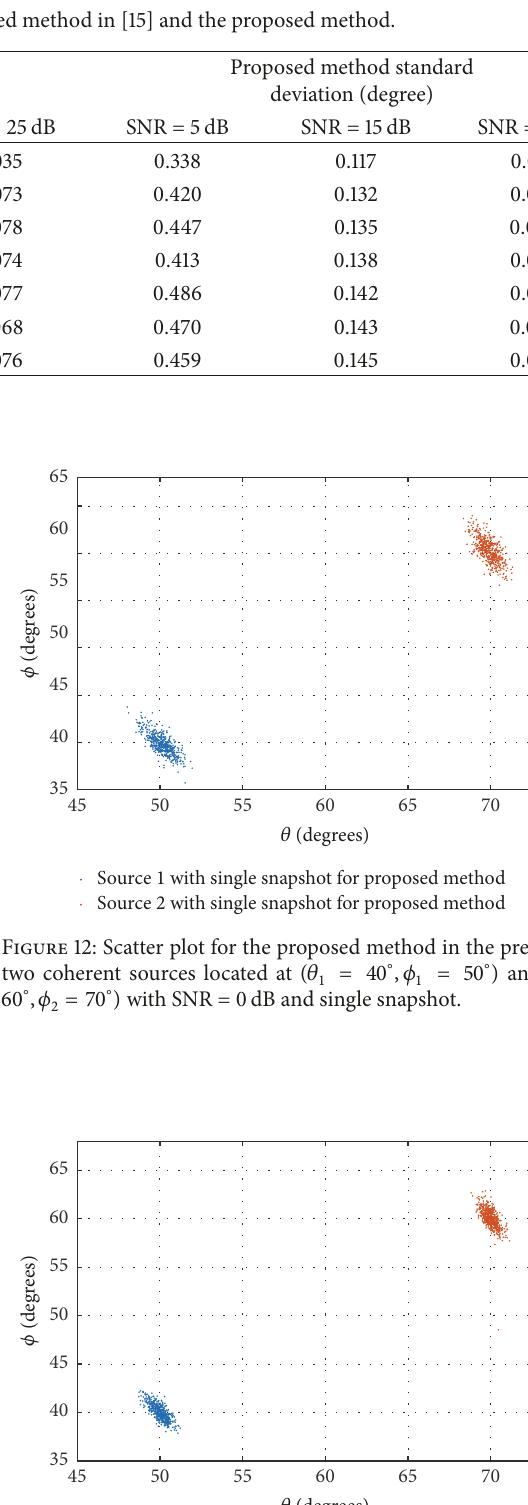
Source 1 for the proposed method Source 2 for the proposed method Figure 11: Scatter plot for the proposed method in the presence of threecoherentsourceslocatedat (𝜃 1 = 50 ∘ , 𝜙 1 = 40 ∘ ) , (𝜃 2 = 60 ∘ , 𝜙 2 = 55 ∘ ) , and (𝜃 = 70 ∘ ,𝜙 = 65 ∘ ) with SNR = 20 dB. 3 3